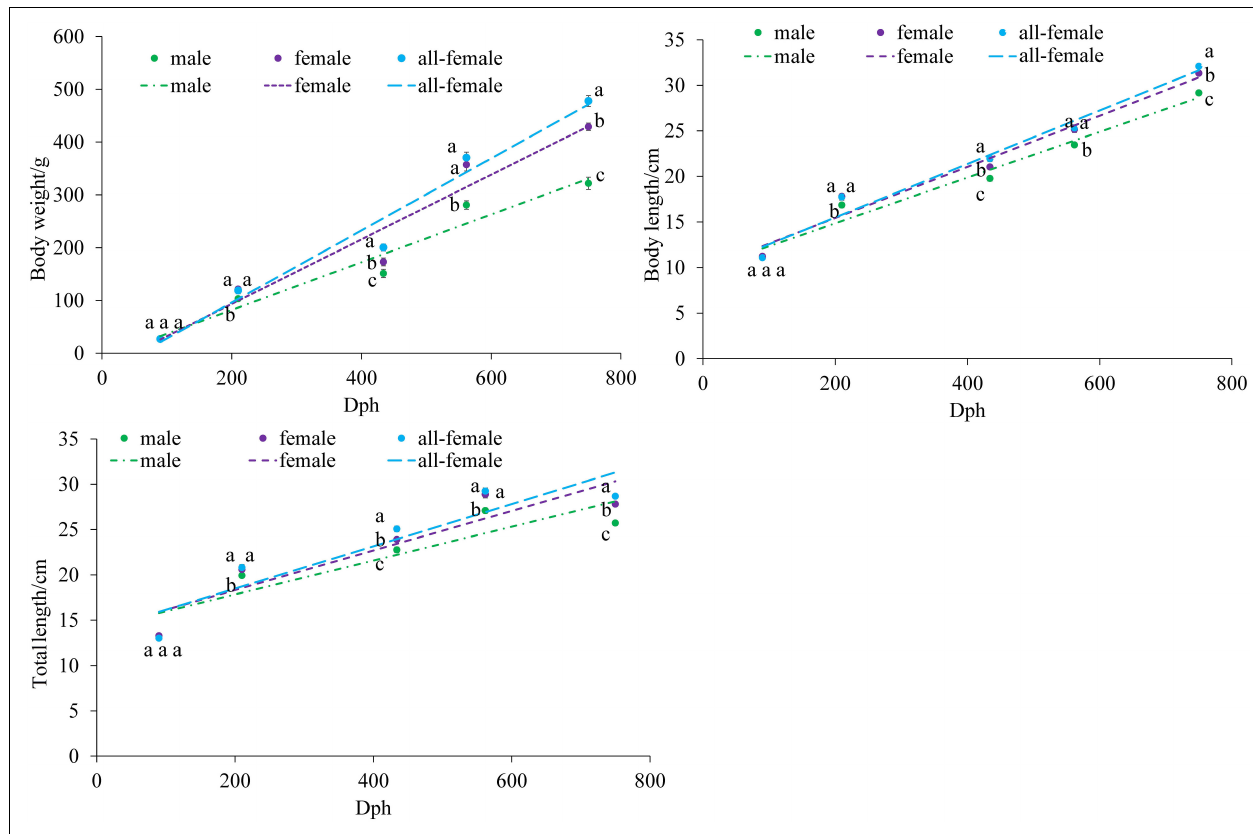
FIGURE 1 | Growth curves of the body weight, body length, and total length of Nibea albiflora male, female, and all-female fish, during an investigation of the composition of the intestinal microbiota. Data with different letters at the same time point represented significant differences ( P < 0.05).